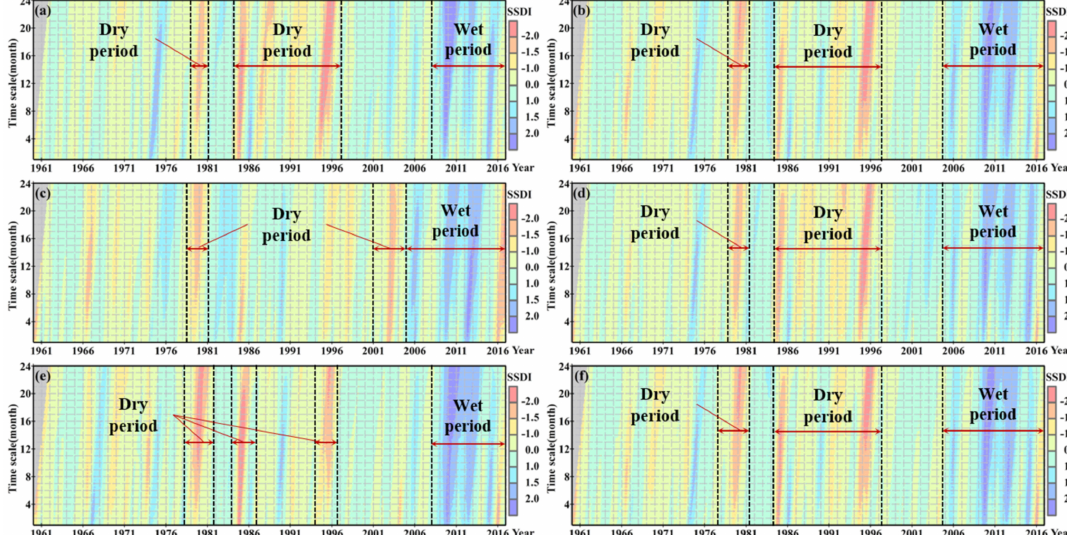
Figure 4. Hovmoller-type diagrams for the temporal variability of the SSDI from 1 to 24-month scales at different subregions: ( a ) Togton River Basin; ( b ) Middle stream; ( c ) Downstream; ( d ) Dam River Basin; ( e ) Qumar River Basin; ( f )